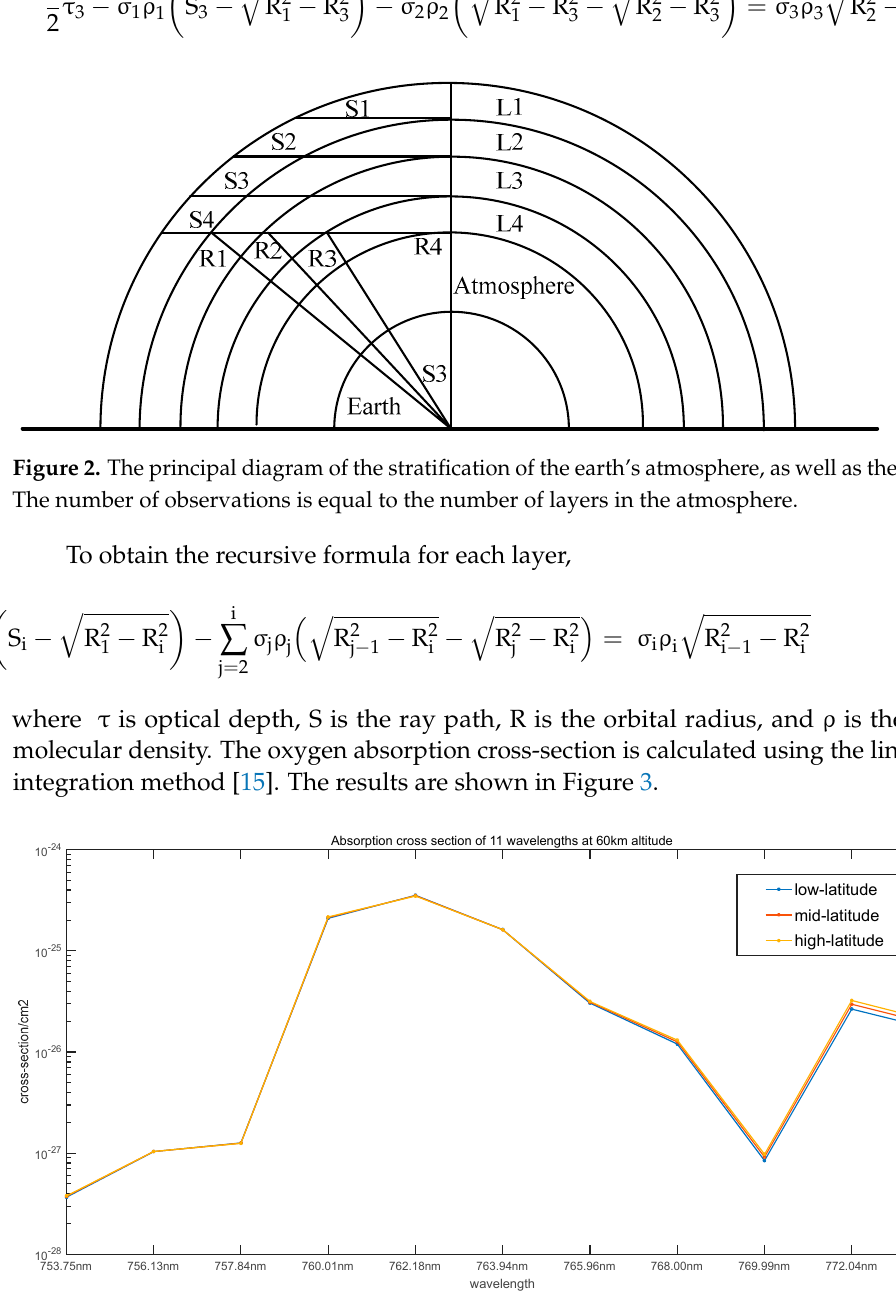
Figure 2. The principal diagram of the stratification of the earth’s atmosphere, as well as the inver- sion. The number of observations is equal to the number of layers in the atmosphere.